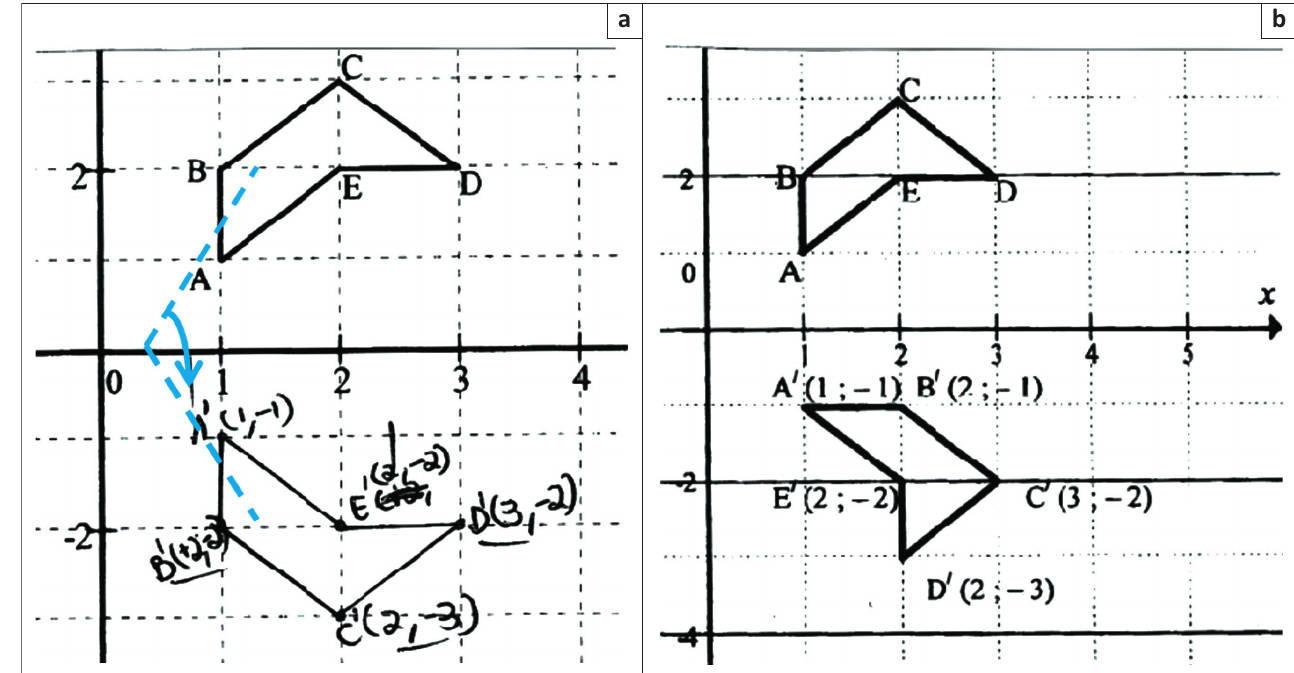
FIGURE 3: Typical student conceptual error on 3.2.2 (a) and the memorandum